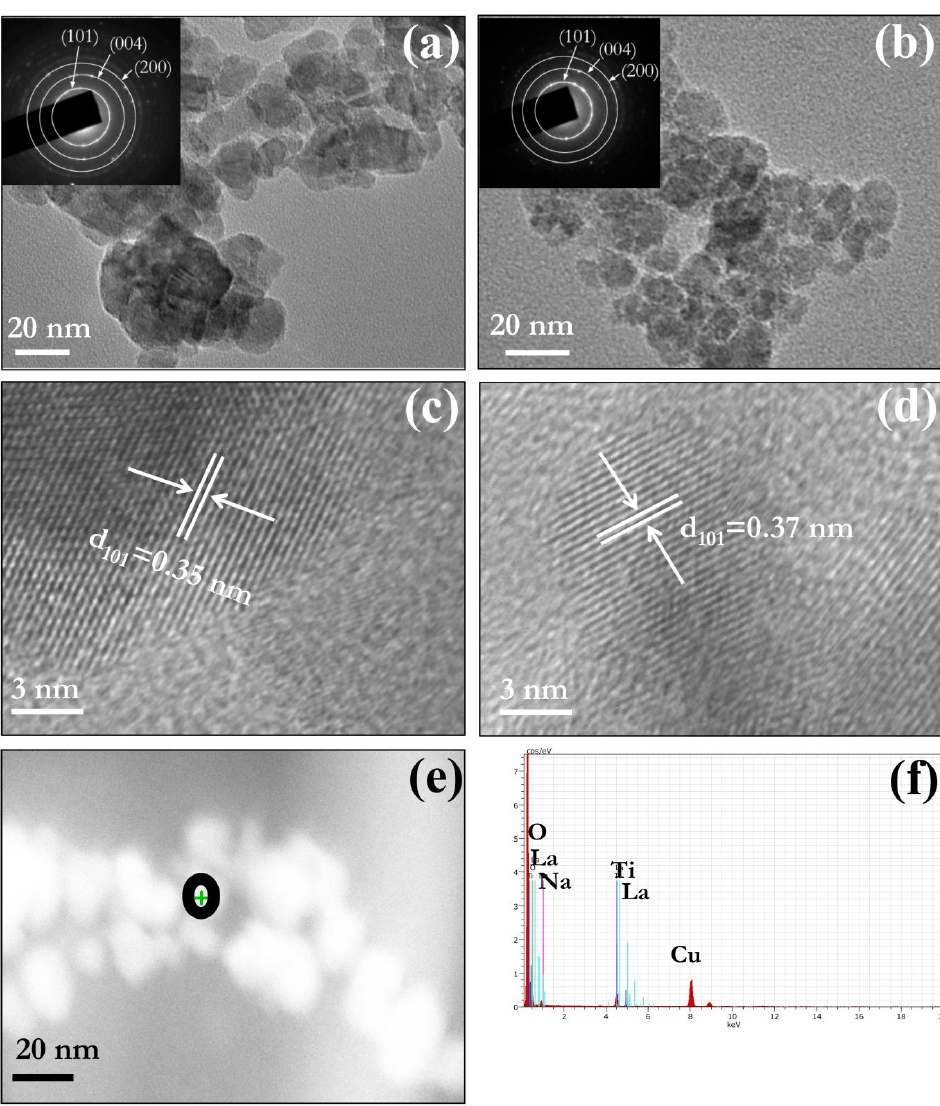
Figure 3. TEM micrograph of ( a ) PT and ( b ) LNT4 nanopowder. Insets in ( a , b ) show SAED patterns of PT and LNT4 respectively. HRTEM images of ( c ) PT and ( d ) LNT4. ( e ) STEM dark field image of cluster of LNT4 nanopowder. ( f ) STEM-EDX point spectrum from an area shown by black circle in ( e